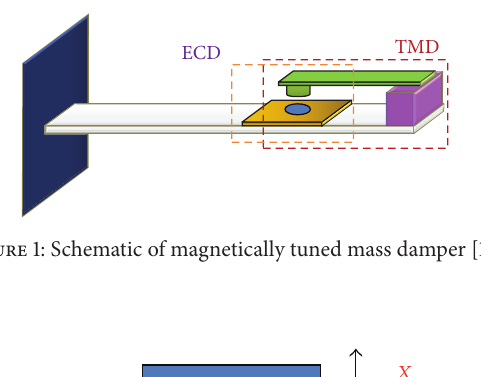
Figure 5: TMD at tip of